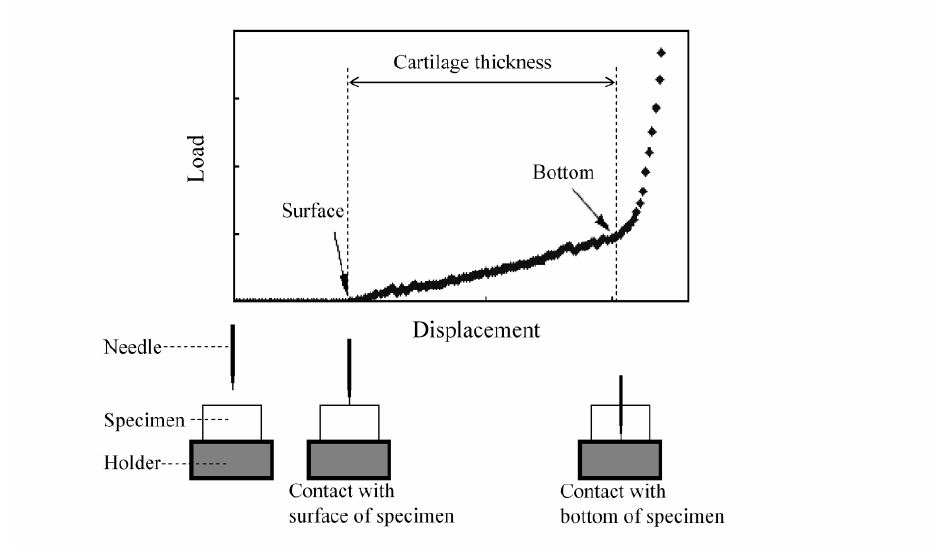
Fig. 3 Displacement and load signals for the determination of cartilage thickness during a needle